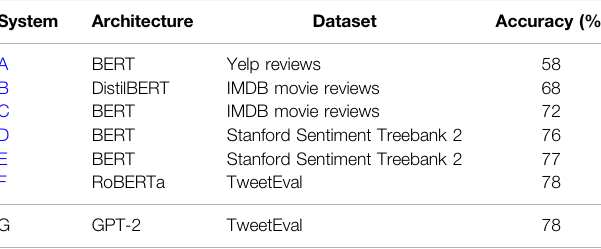
TABLE 6| Comparison ofthesentimentanalysisaccuracy ofseveralstate-of-the- art transformer-based sentiment analysis systems. System